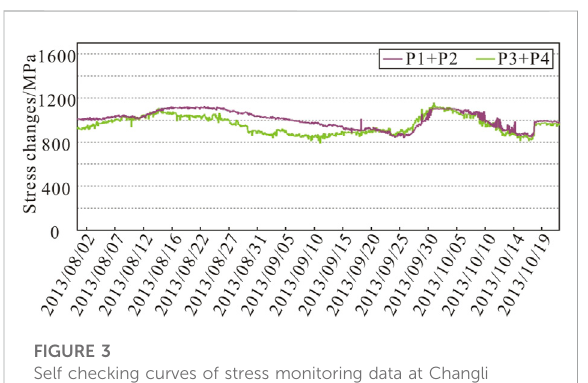
FIGURE 3 Self checking curves of stress monitoring data at Changli piezomagnetic stress monitoring